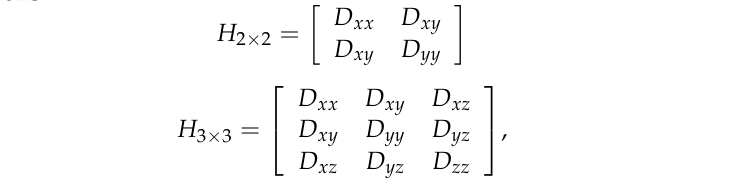
Figure 11. Building blocks of the feature detection. Since both the matrices are symmetric, only six elements need to be determined. Fig- ure 12 shows the realized structure, where pixel inputs come from the corresponding po- sitions shown in Figure 10.